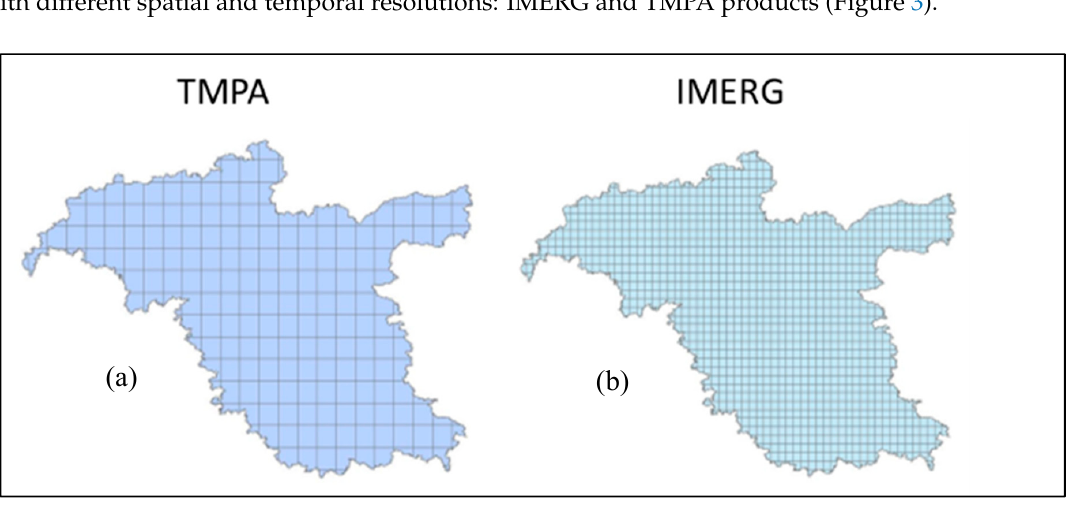
Figure 3. Spatial resolution and footprint comparison between two satellite precipitation products: ( a ) tropical rainfall measurement mission multi-satellite precipitation analysis (TMPA) (0.25 ◦ ) and ( b ) integrated multi-satellite retrievals for global precipitation measurement (IMERG) (0.1 ◦ ).